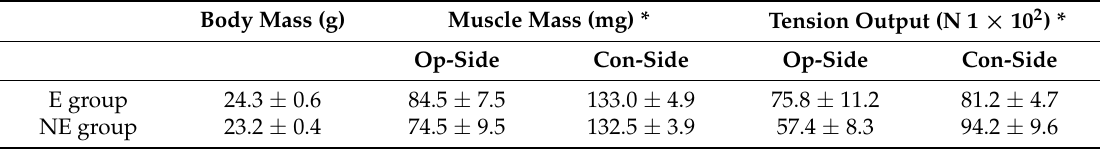
Table 1. Final Body mass, and downstream muscle mass and tension output (8 weeks after